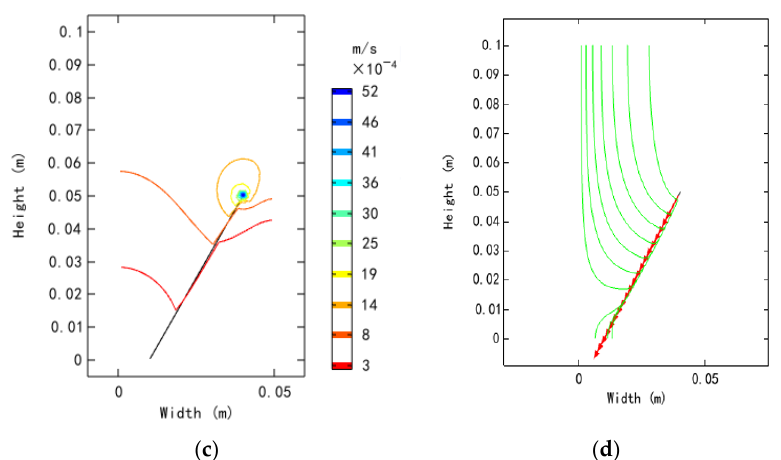
Figure 18. Distribution of gas velocity in the lower fracture model. ( a ) Gas velocity in the coal matrix; ( b ) gas velocity field in the coal matrix; ( c ) gas velocity in lower fracture; ( d ) gas velocity filed in lower fracture.